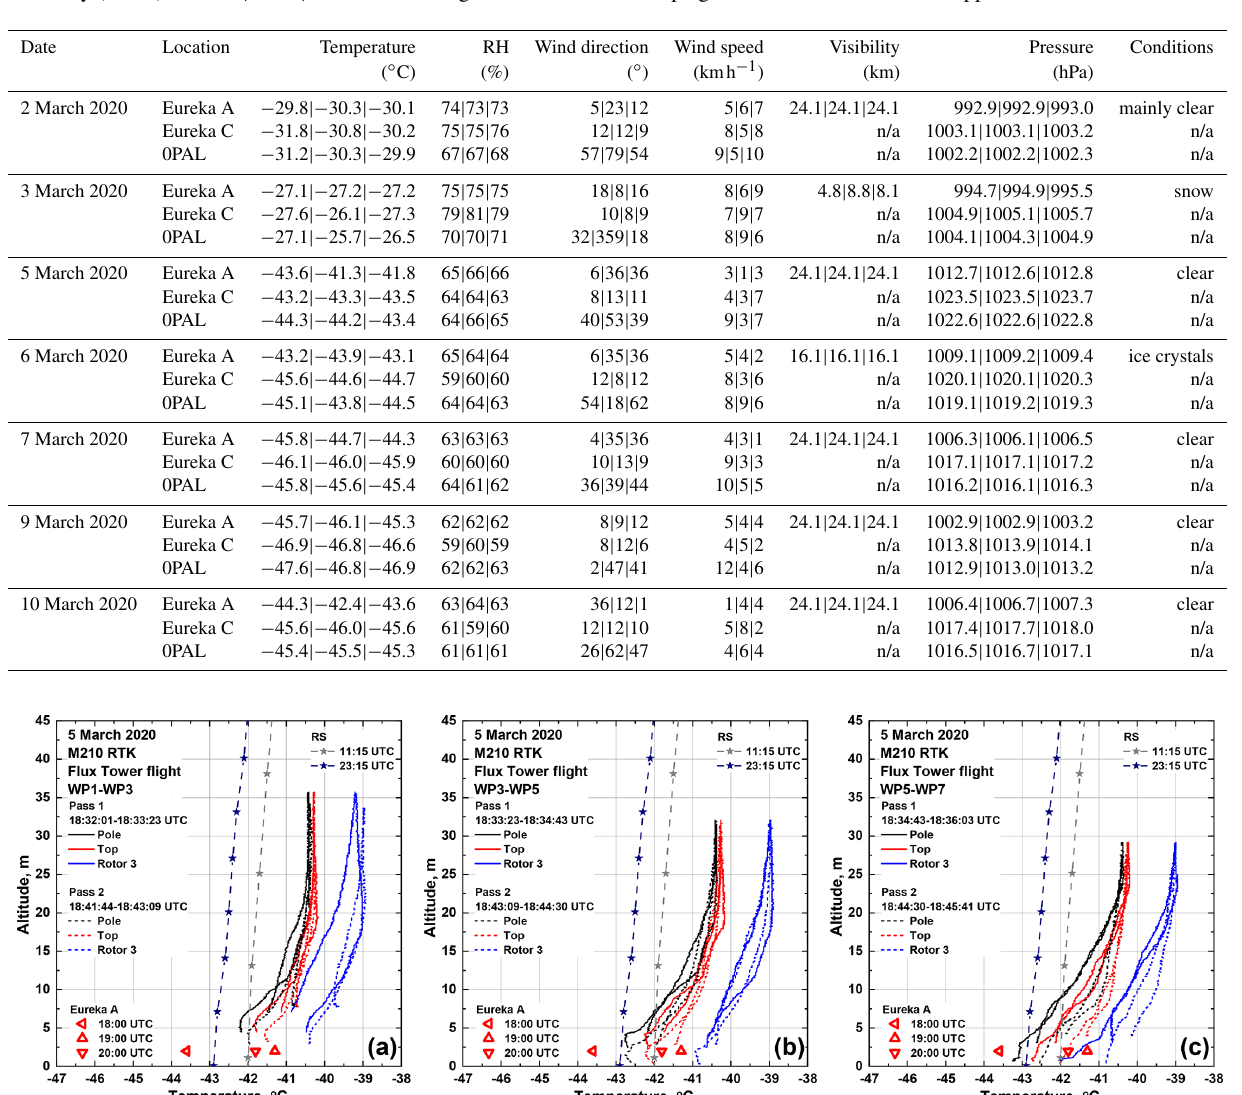
Table 2. Meteorological conditions at the Eureka Aerodrome (Eureka A), Eureka Climate (Eureka C), and Zero Altitude PEARL Auxiliary Laboratory (0PAL) at 18:00 | 19:00 | 20:00UTC during the measurement campaign in March 2020. n/a – not applicable